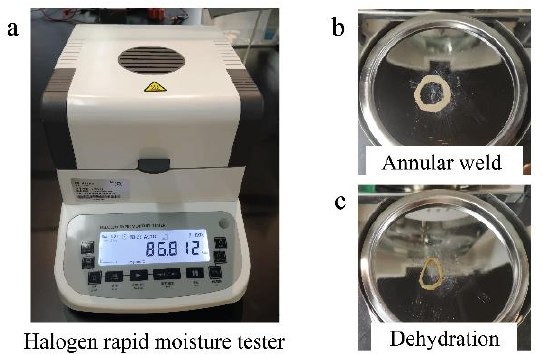
Figure 4. ( a ) Measurement of moisture content by the halogen rapid moisture tester. The decrease in moisture content causes a rapid increase in tissue impedance. ( b ) Annular weld after welding. Only the annular weld area of the small intestine is kept for moisture determination after welding.